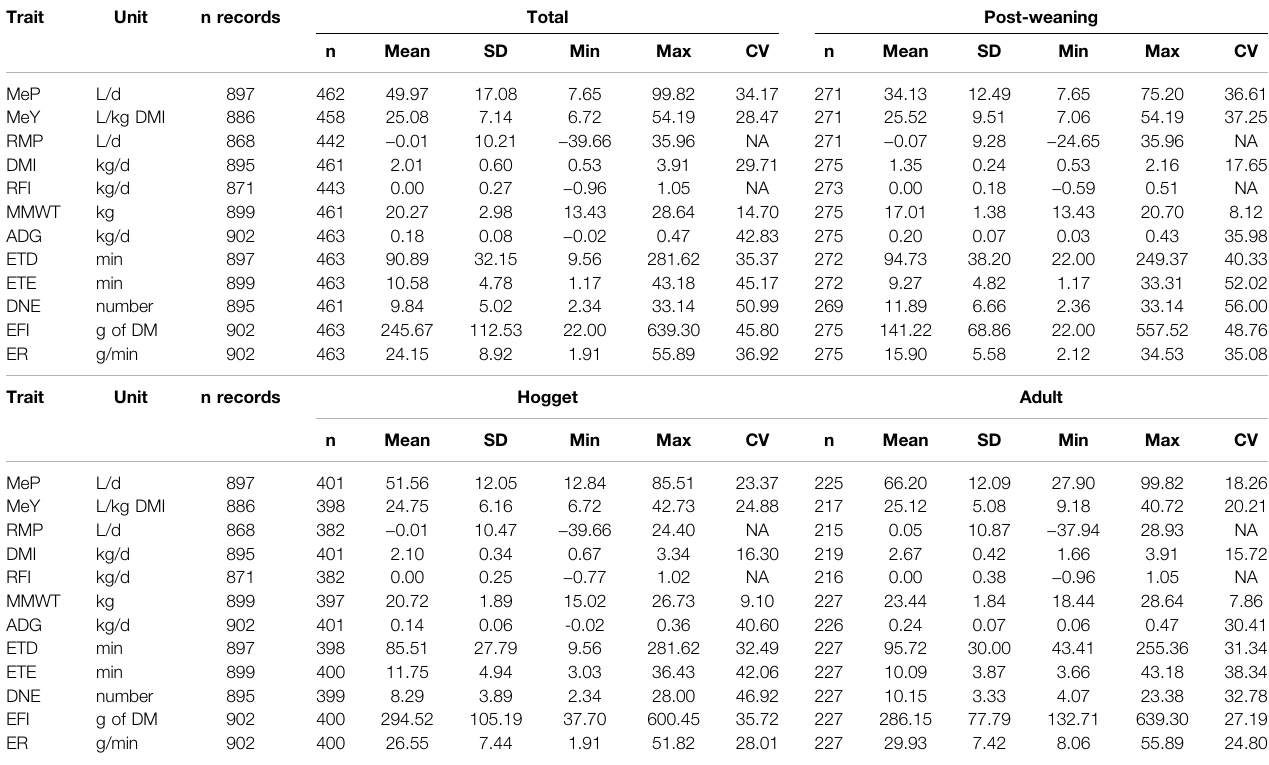
TABLE3| DescriptivestatisticsoftraitsinAustralianMaternalCompositeewes.Traits:Methaneproduction(MeP),methaneyield(MeY),residualmethaneproduction(RMP), dry matterintake (DMI), residual feedintake(RFI), metabolicmid-weight(MMWT),averagedaily gain(ADG), eating time per day (ETD),eating time per eating event (ETE), daily number of eating events (DNE), event feed intake (EFI), and eating rate (ER). Trait